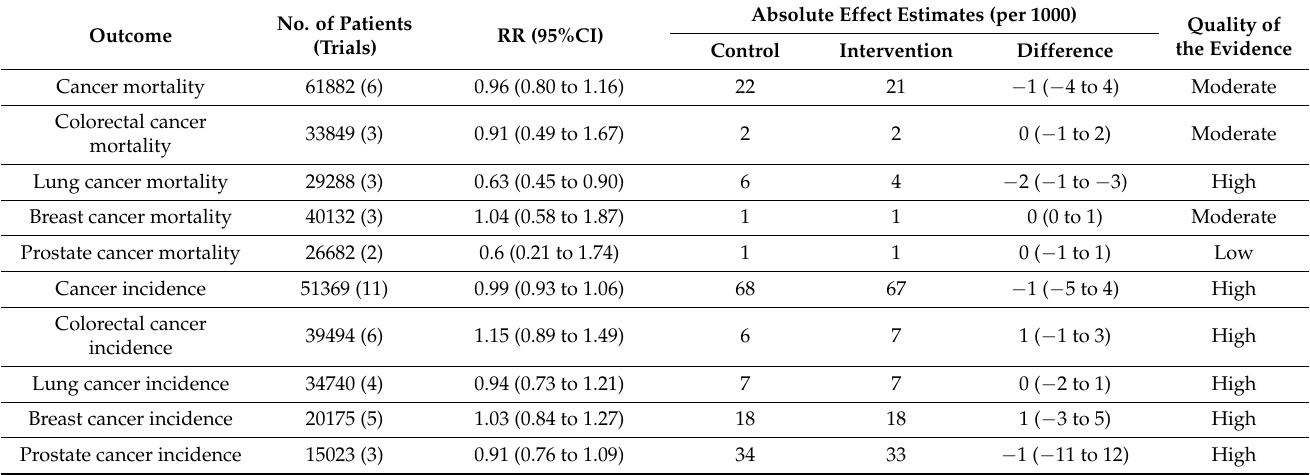
Table 2. Summary of Findings and Strength of